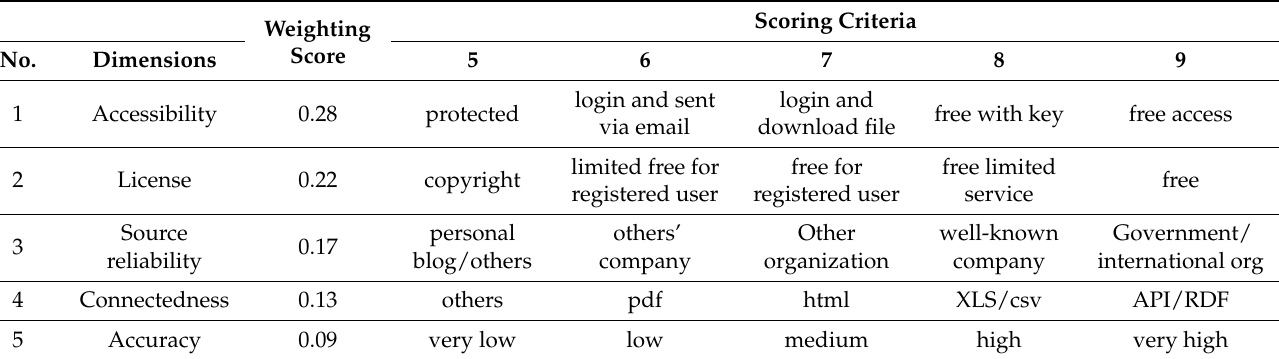
The eight dimensions of data quality assessment in Small Farm Management Information